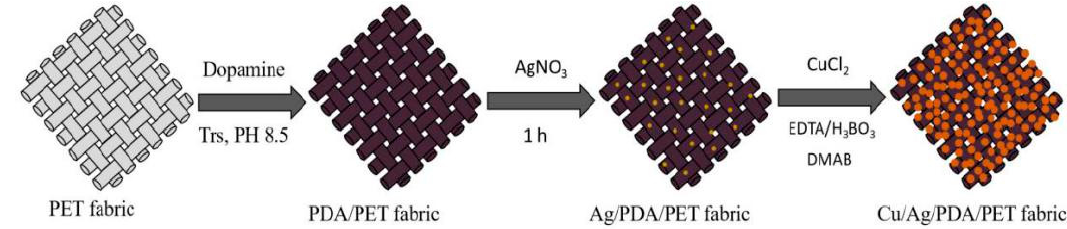
Figure 1. Schematic diagram of the synthesis process of Cu/Ag/polydopamine (PDA)/polyester (PET) fabrics.